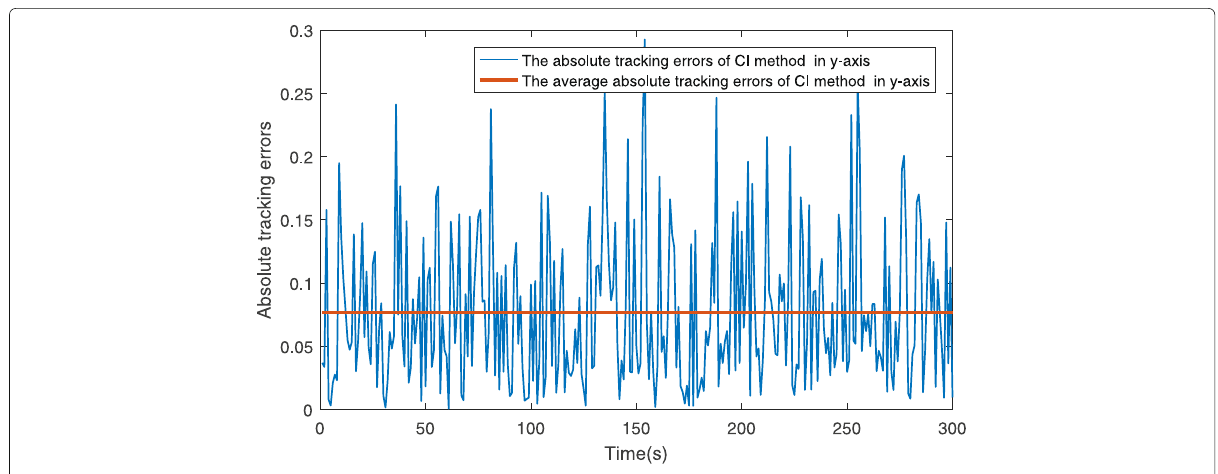
Fig. 8 The absolute tracking errors in of CI method in y -axis with a i = 10